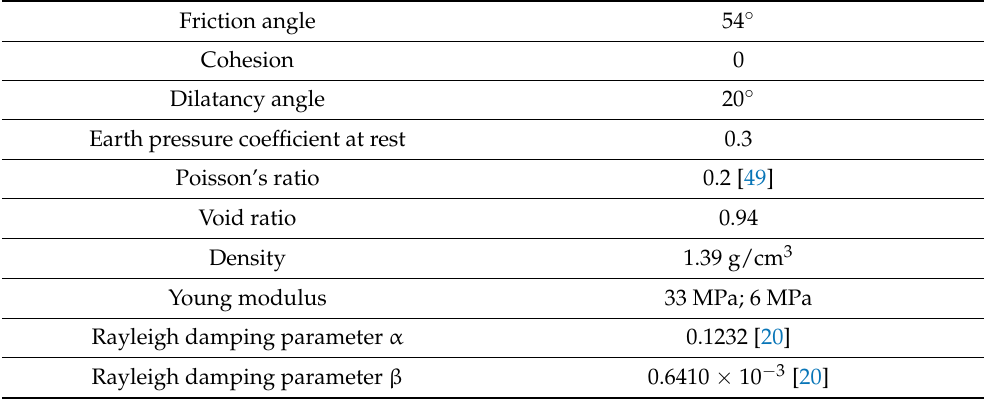
Table 2. Geotechnical parameters of the regolith layer employed in the FEM calculation.